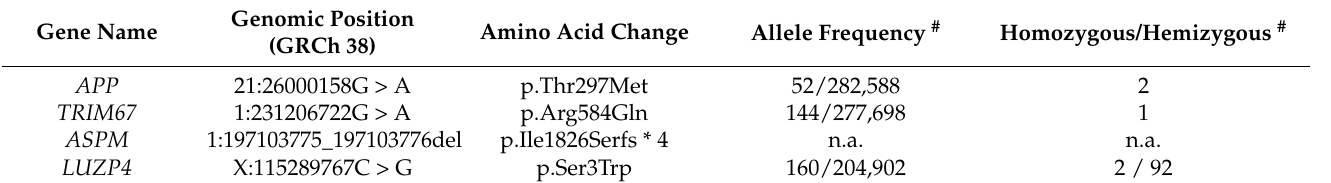
Table 2. Homozygous and hemizygous variants with CADD * score > 20 detected in the index patient (II.2).